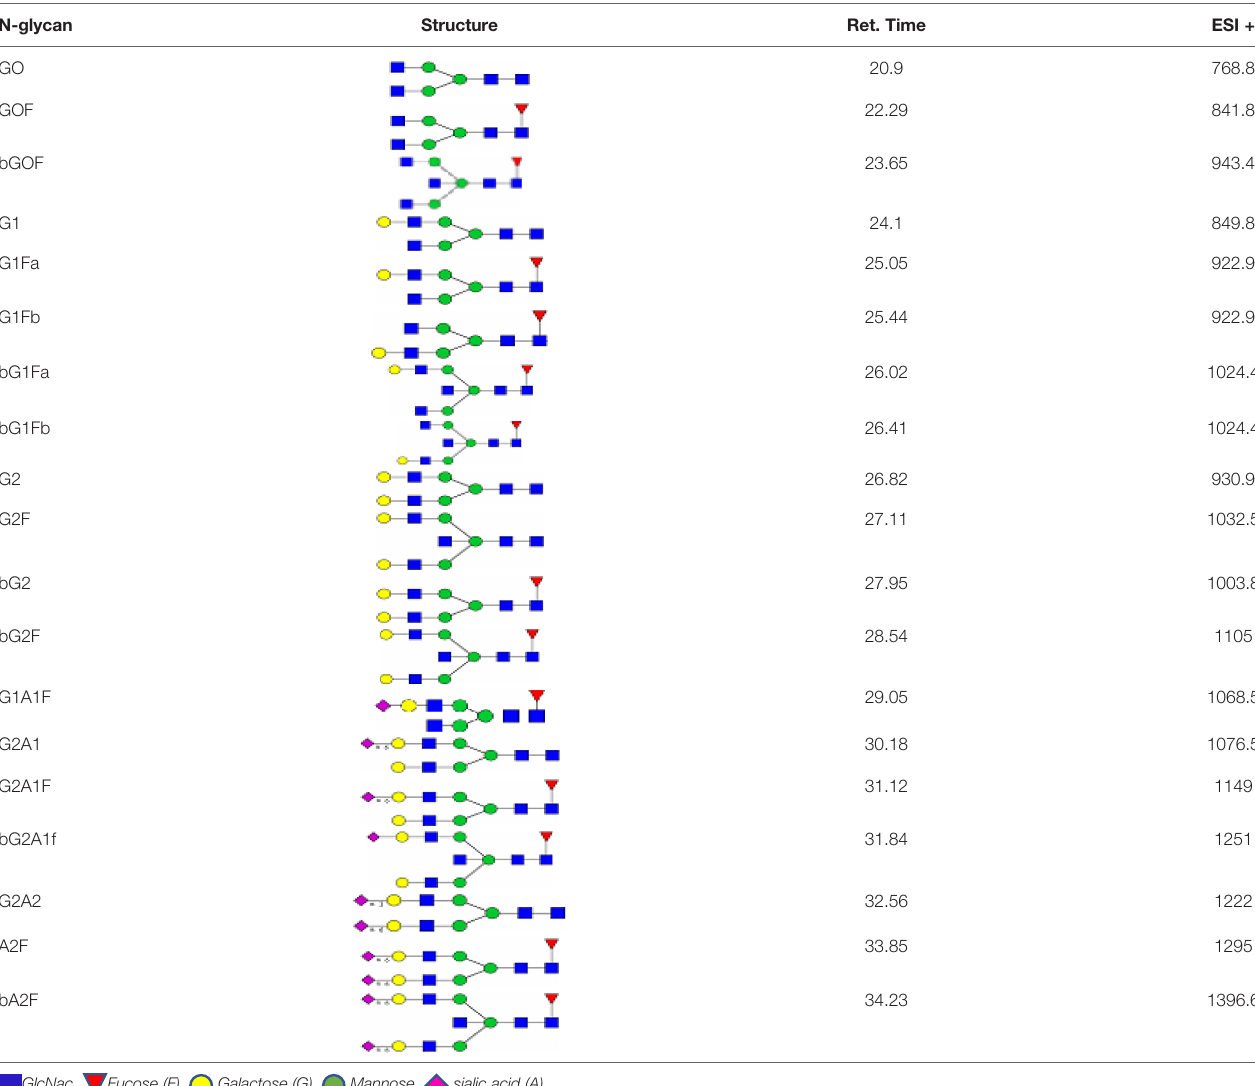
TABLE 2 | Detected glycan